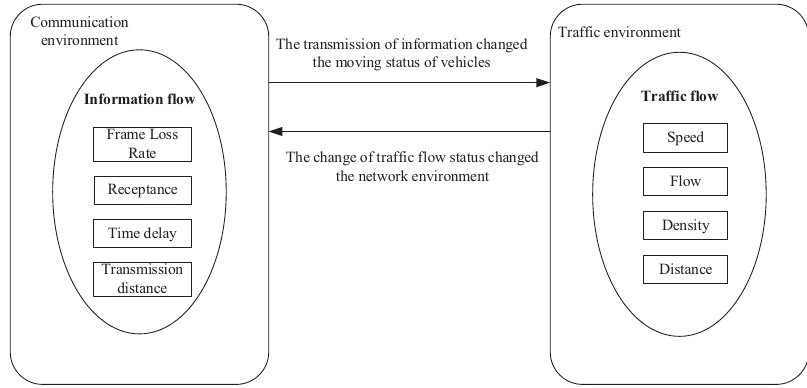
Figure 3 Interactional relationship of traf fi c fl ow and information fl